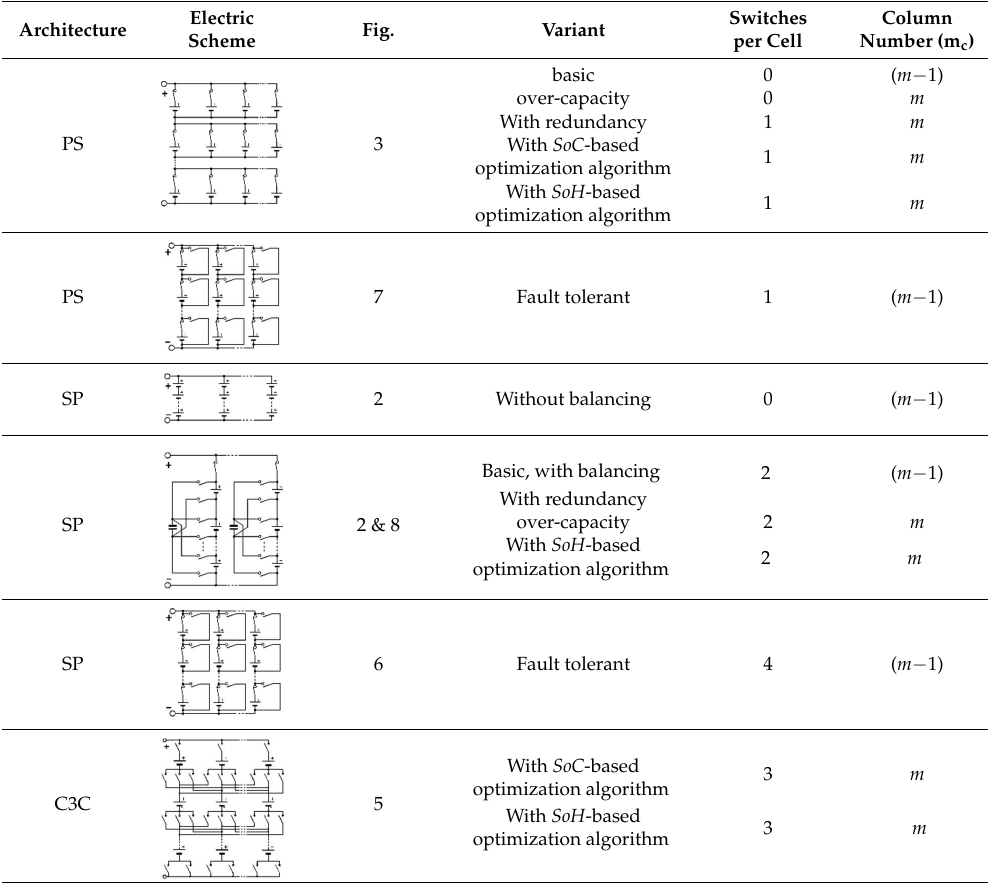
Table 1. Simulated architectures and variants.